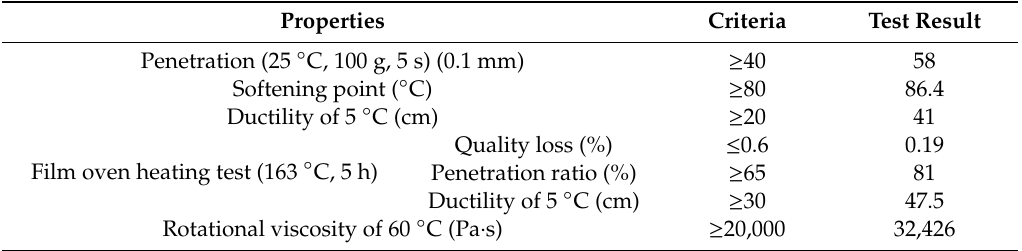
Table 8. Technical index of high viscosity modified